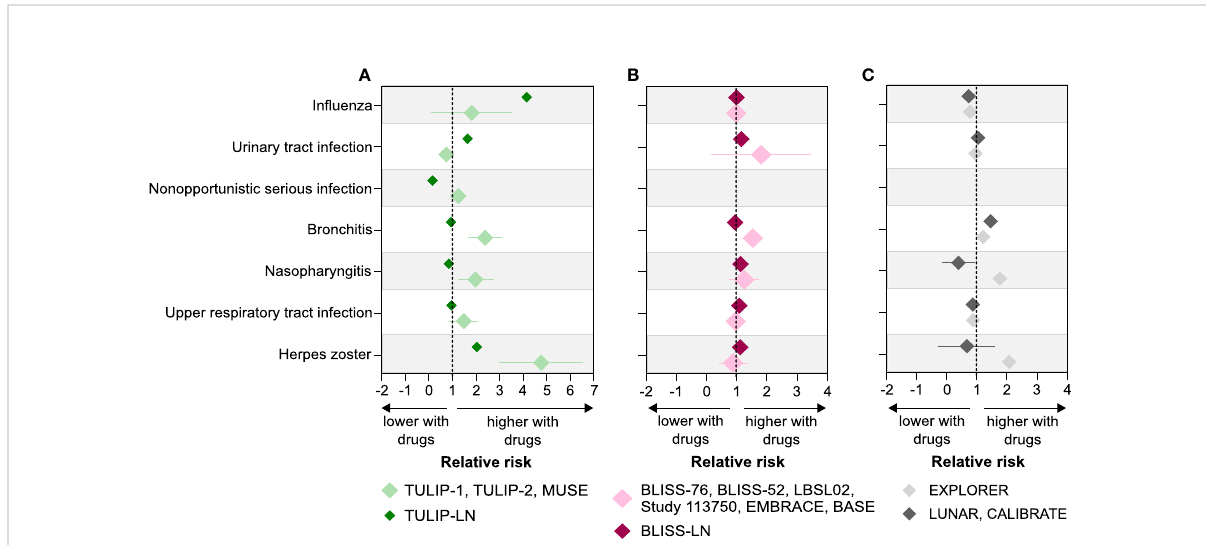
FIGURE 5 Relative risk of infectious complications in SLE without versus with active LN trials. (A – C) Relative risk (RR) of infectious complications including herpes zoster, upper respiratory tract infection, nasopharyngitis, bronchitis, nonopportunistic infection, urinary tract infection, and in fl uenza was calculated for the SLE with and without active LN trials based on the prevalence of infections for anifrolumab (A) , belimumab (B) , and rituximab (C) as described in the methods. A RR of greater than 1 indicates that the risk of infectious complications is higher with biological drugs compared with placebo in SLE without and with active LN patients, while a RR of less than 1 indicates a lower risk. Data are presented as mean of RR ± standard deviation